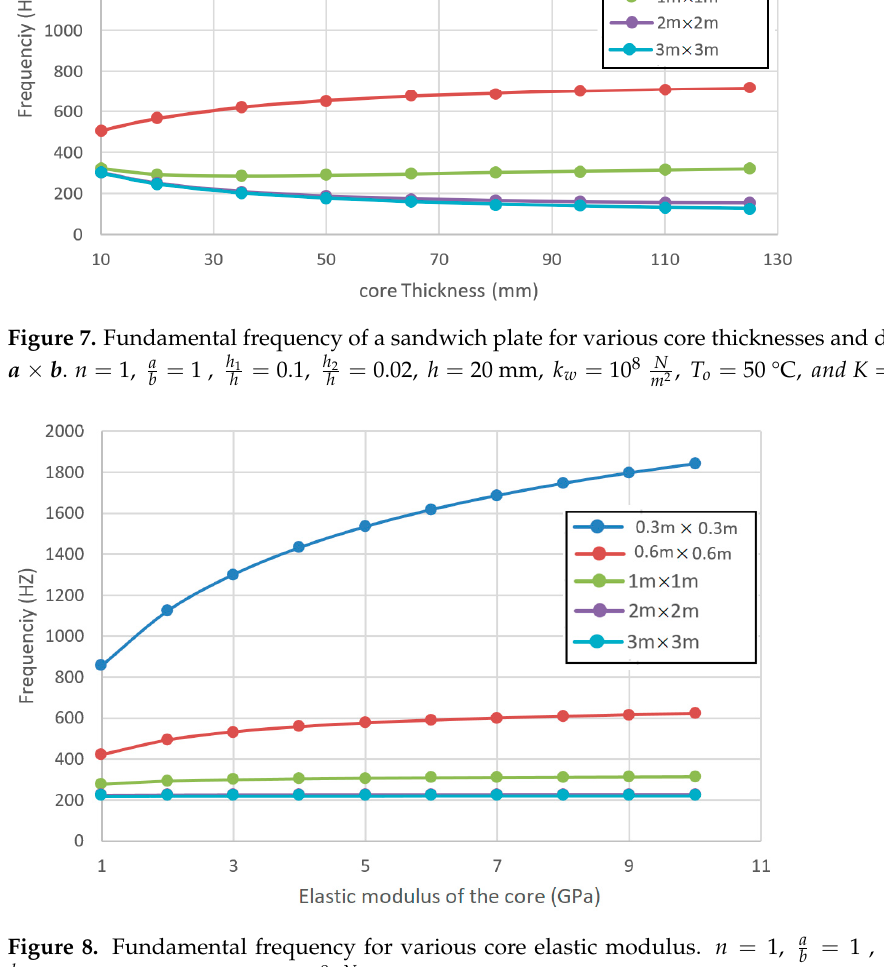
κ , T o = 23 °C, K = ,𝑇 (cid:3042) = 23 ℃, = 0.616. m 2 (cid:3040) (cid:3118)